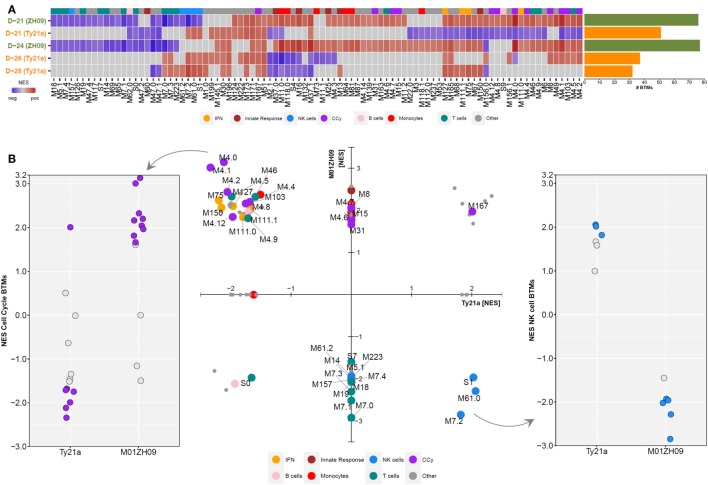
Gene Set Enrichment Analysis was performed at each time point following Ty21a and M01ZH09 vaccination. (A) Tile graph with significant blood transcriptional modules (BTMs) (adjusted p < 0.05) following vaccination (blue: negative enrichment; red: positive enrichment). Non-significant BTMs were set to normalized enrichment score (NES) = 0 (gray: not significant). Bar graph to the right indicates the number of significantly enriched BTMs at each time point/group. (B) NESs of BTMs at the D-21 time point following vaccination. Middle: scatter plot displaying NES of significantly enriched BTMs (adjusted p < 0.05) following either Ty21a (x-axis) or M01ZH09 (y-axis) vaccination. If a BTM was not significantly enriched in one of the two groups, the respective NES was set to 0. Colors represent different BTM categories. Dot plots depict enrichment scores of cell cycle (left) and NK cell (right) related modules. Solid dots: p < 0.05.